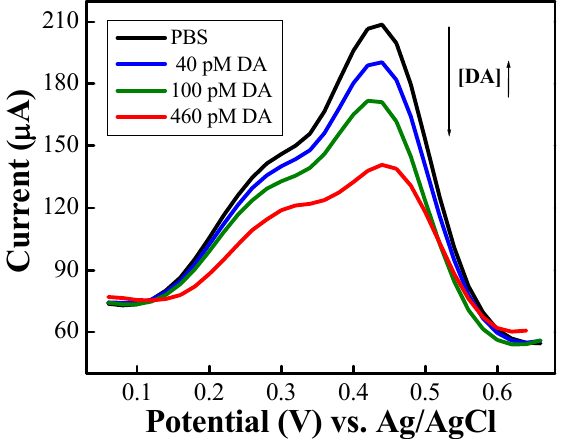
Figure 7. Differential pulse voltammograms of the composite in PBS and upon addition of different concentrations of dopamine. Potential scan rate: 100 mV  s -1 ; pulse amplitude: 50 mV; pulse width: 50 s. (Reproduced with permission from the American Chemical Society